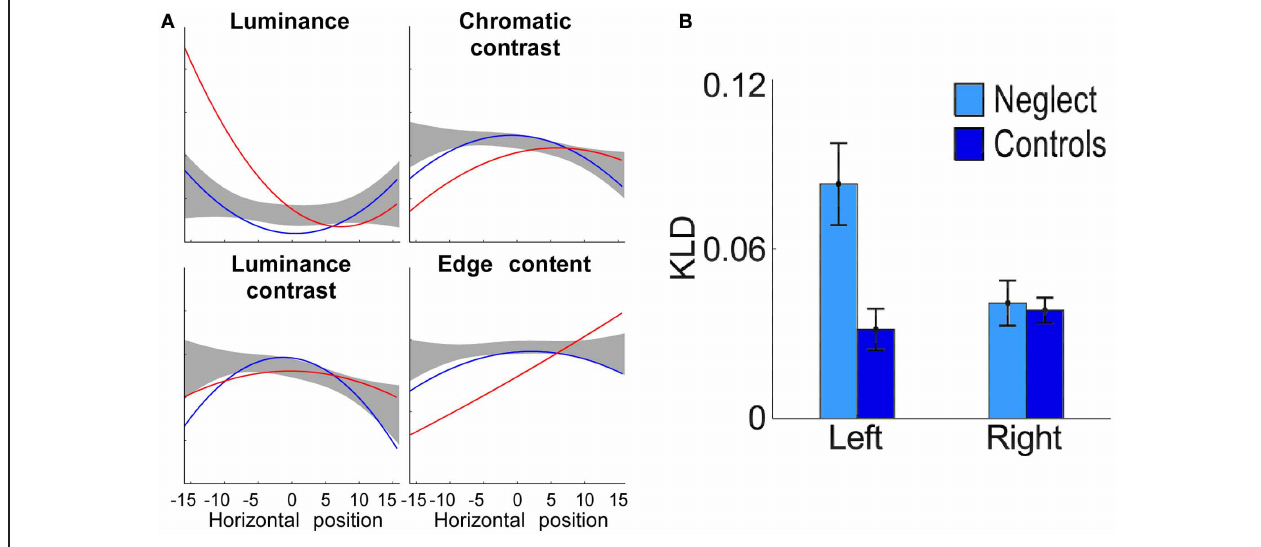
FIGURE 3 | (A) Local image content as a function of the horizontal position of fixations, computed for patients with neglect (red line) and control patients (blue line). Note the strong deviation of luminance and edge content in the data of neglect patients as compared to control data (grey area: 99% confidence interval of healthy controls; adapted from Ptak et al., 2009). (B) Fixated image